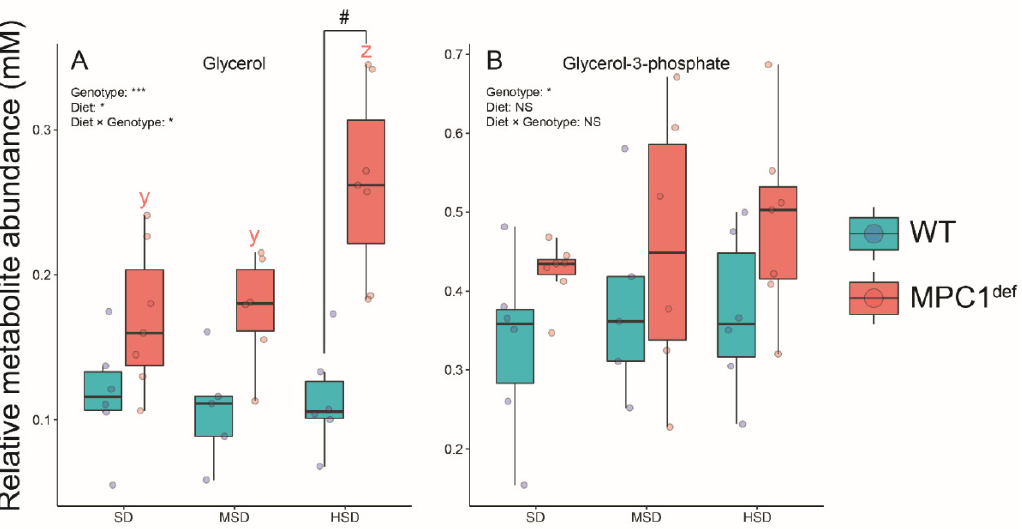
Figure 6. Polyol levels measured in Drosophila melanogaster WT and MPC1 def exposed to the different experimental diets (SD, MSD, or HSD): ( A ) glycerol levels and ( B ) glycerol-3-phosphate levels. Results correspond to the mean ± SEM for each condition (N = 6–7). Statistical analysis: stars represent statistical results from ANOVAs with * p < 0.05, and *** p < 0.001; # represents significant differences between genotypes for each experimental diet detected using the estimated marginal means method; and letters denote differences between experimental diets for each genotype, with “y” and “z” representing differences between the MPC1 def flies.